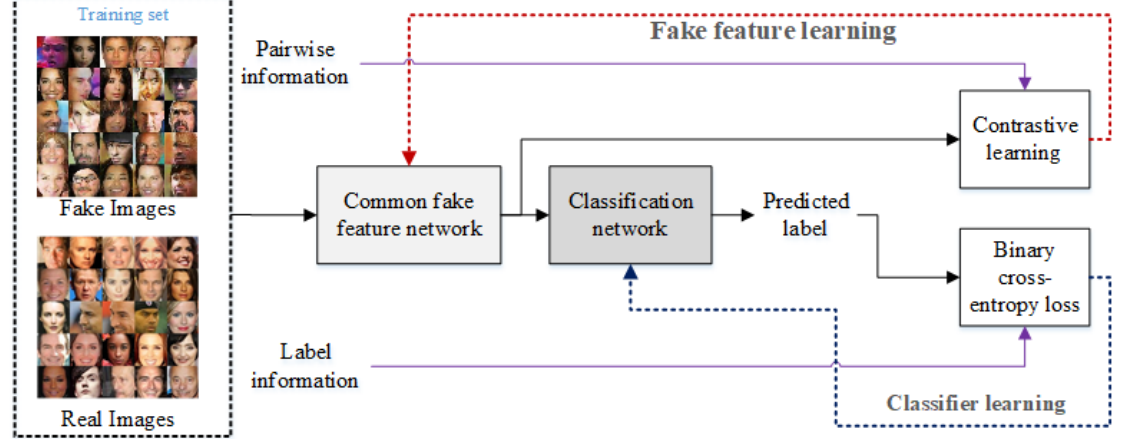
Figure 1. The flowchart of the proposed fake face detector based on the proposed common fake feature network with the two-step learning